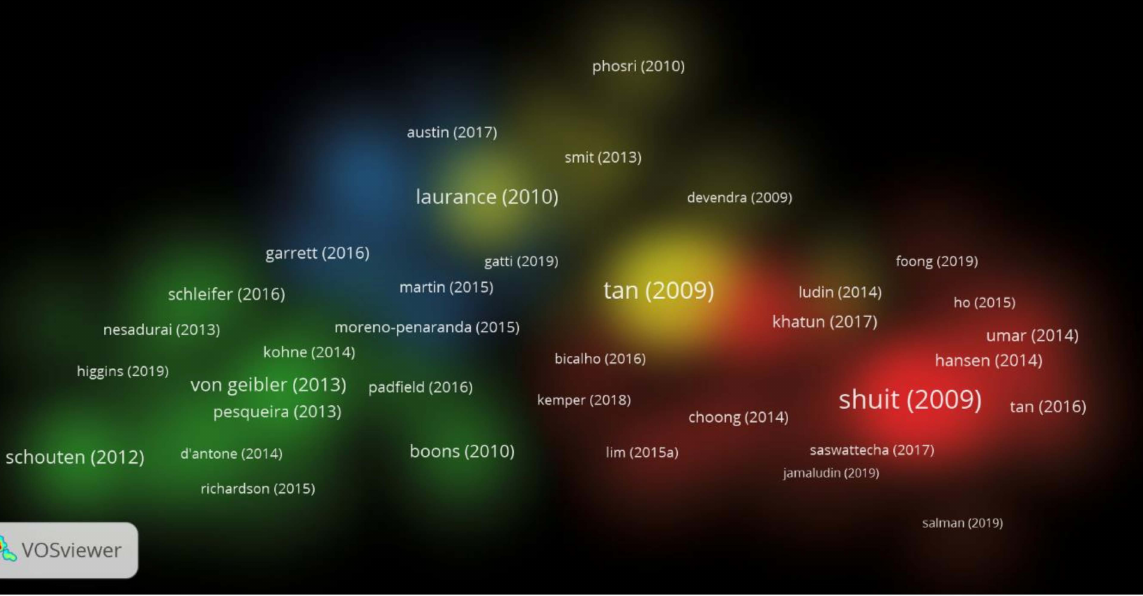
Figure 6. Bibliometric coupling